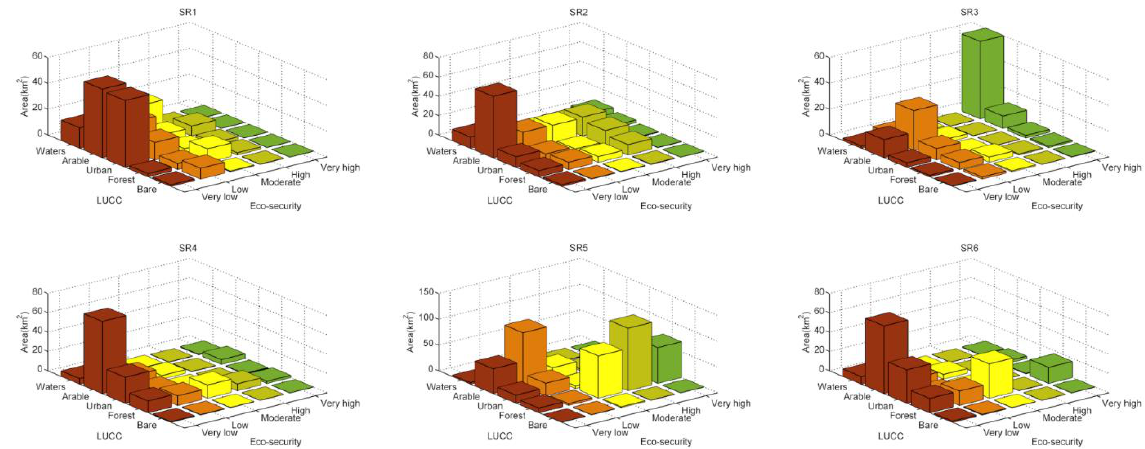
Figure 4. Carrying capacity of land resources under the ecological constraint for each sub-region in Daye.